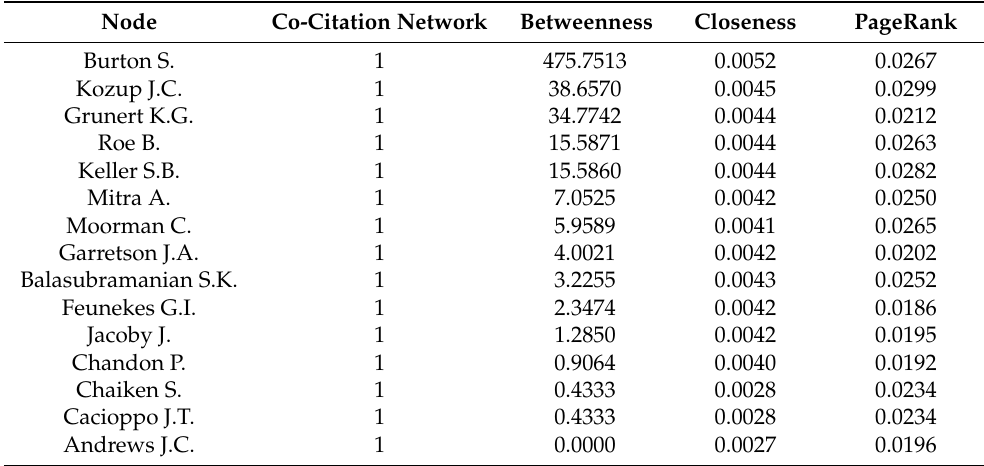
Table 5. The relative strength of the nodes within the co-citation network. Node Co-Citation Network Betweenness Closeness PageRank Burton S. 1 475.7513 0.0052 0.0267 Kozup J.C. 1 38.6570 0.0045 Grunert K.G.